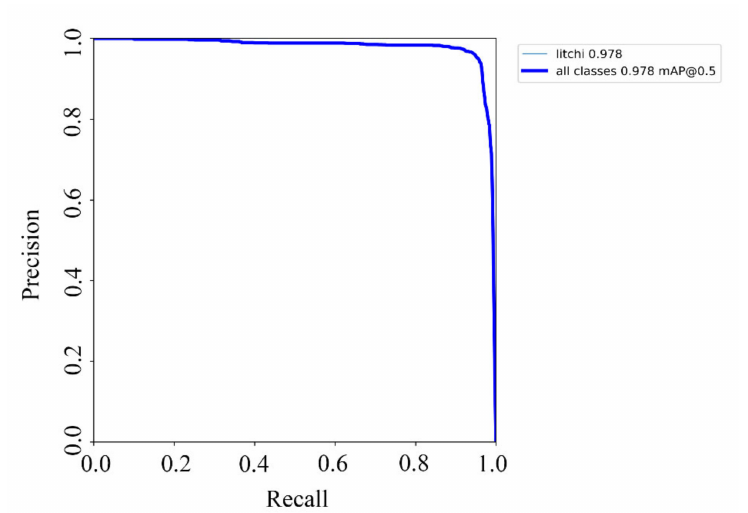
Figure 11. P-R curve of the model.